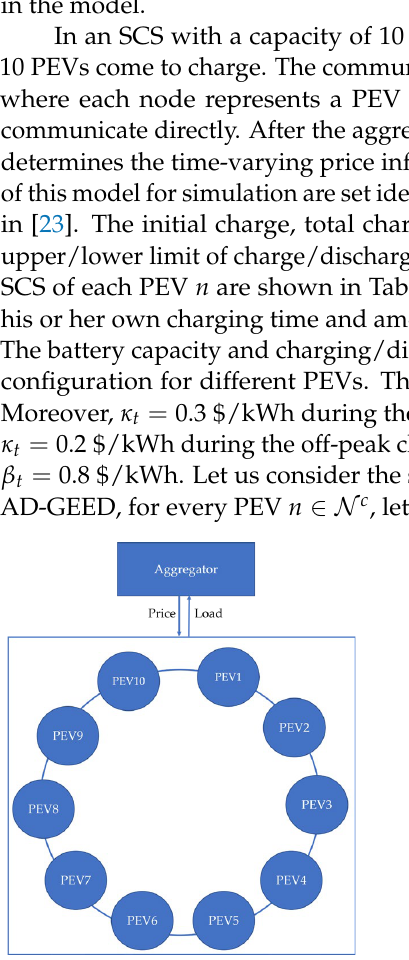
Figure 1. Communication network of 10 PEVs.